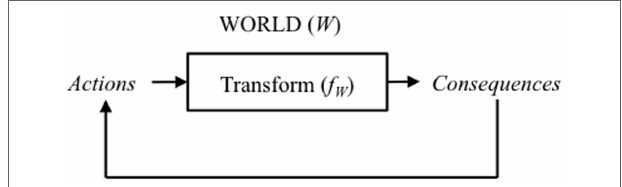
FIGURE 3 | Illustration of the continuous cycle of cause-and-effect in a world that obeys the ordinary Laws of Physics.